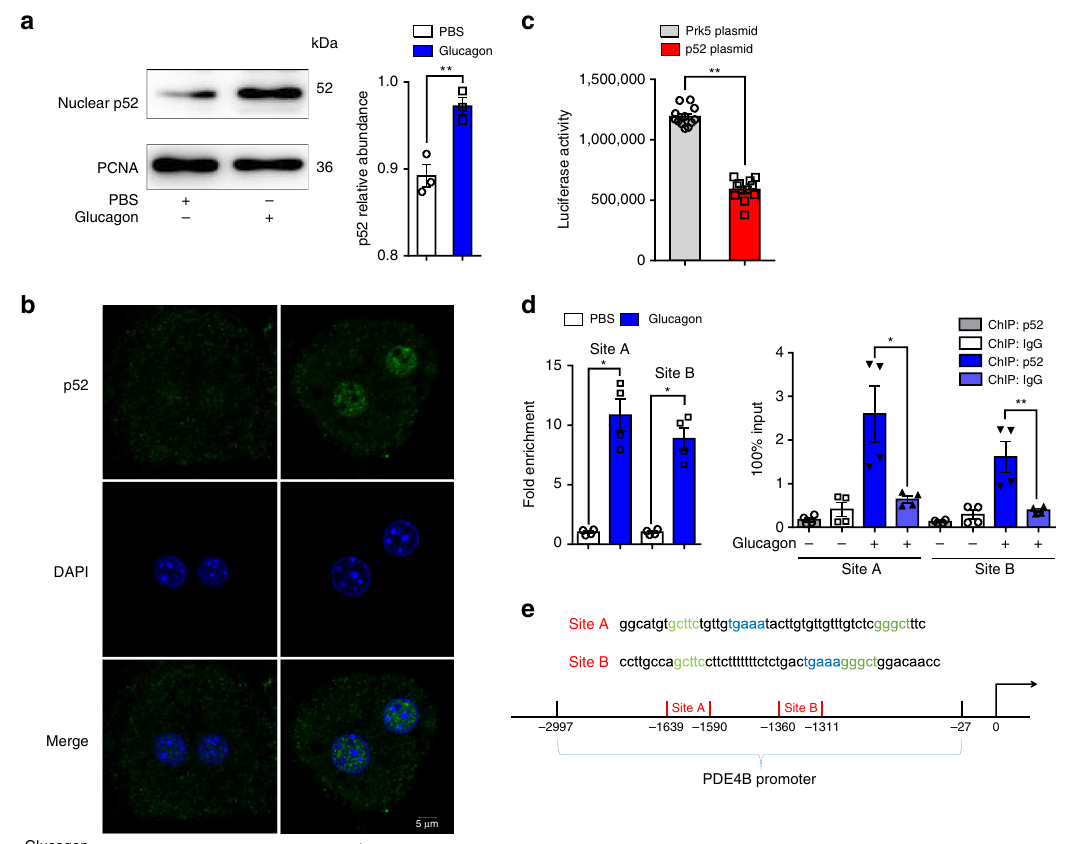
Fig. 4 p52 binds to the PDE4B promoter and reduces its transcription. a The protein level of p52 in cell nuclei when exposed to glucagon (100 nM, 1 h). The PCNA level was used for normalization ( n = 3). b Representative confocal images of primary hepatocytes exposed to glucagon (100 nM, 1 h). Scale bar represents 5 μ m. c Luciferase reporter assay for inhibition effect of p52 on PDE4B gene promoter. The PDE4B luciferase reporter was co-transfected with p52 plasmid (1 µ g) in 293 T cells. The luciferase activity was normalized with the internal control (Renilla luciferase, n = 12). d ChIP analysis to detect p52 binding to the PDE4B promoter. HepG2 cells were stimulated by glucagon for 1 h. Equal amounts of chromatin (DNA) were subjected to the ChIP assay with NF- κ B2-speci fi c antibody. Mice IgG and protein A/G beads alone were used as negative controls. p52 occupancy of the PDE4B promoter is shown relative to background signal with mice IgG control antibody. The ChIP analysis data are shown without normalization as 100% input ( n = 4). e The probable p52-binding sites identi fi ed in the PDE4B promoter region. PBS phosphate buffer solution, PDE phosphodiesterase, PCNA proliferating cell nuclear antigen, DAPI 4 ’ ,6-diamidino-2-phenylindole. The data are presented as the mean ± SEM. Statistical differences between pairs of groups were determined by a two-tailed Student ’ s t -test. * p < 0.05 vs. control group, ** p < 0.01 vs. control group. Source data are provided as a Source Data fi